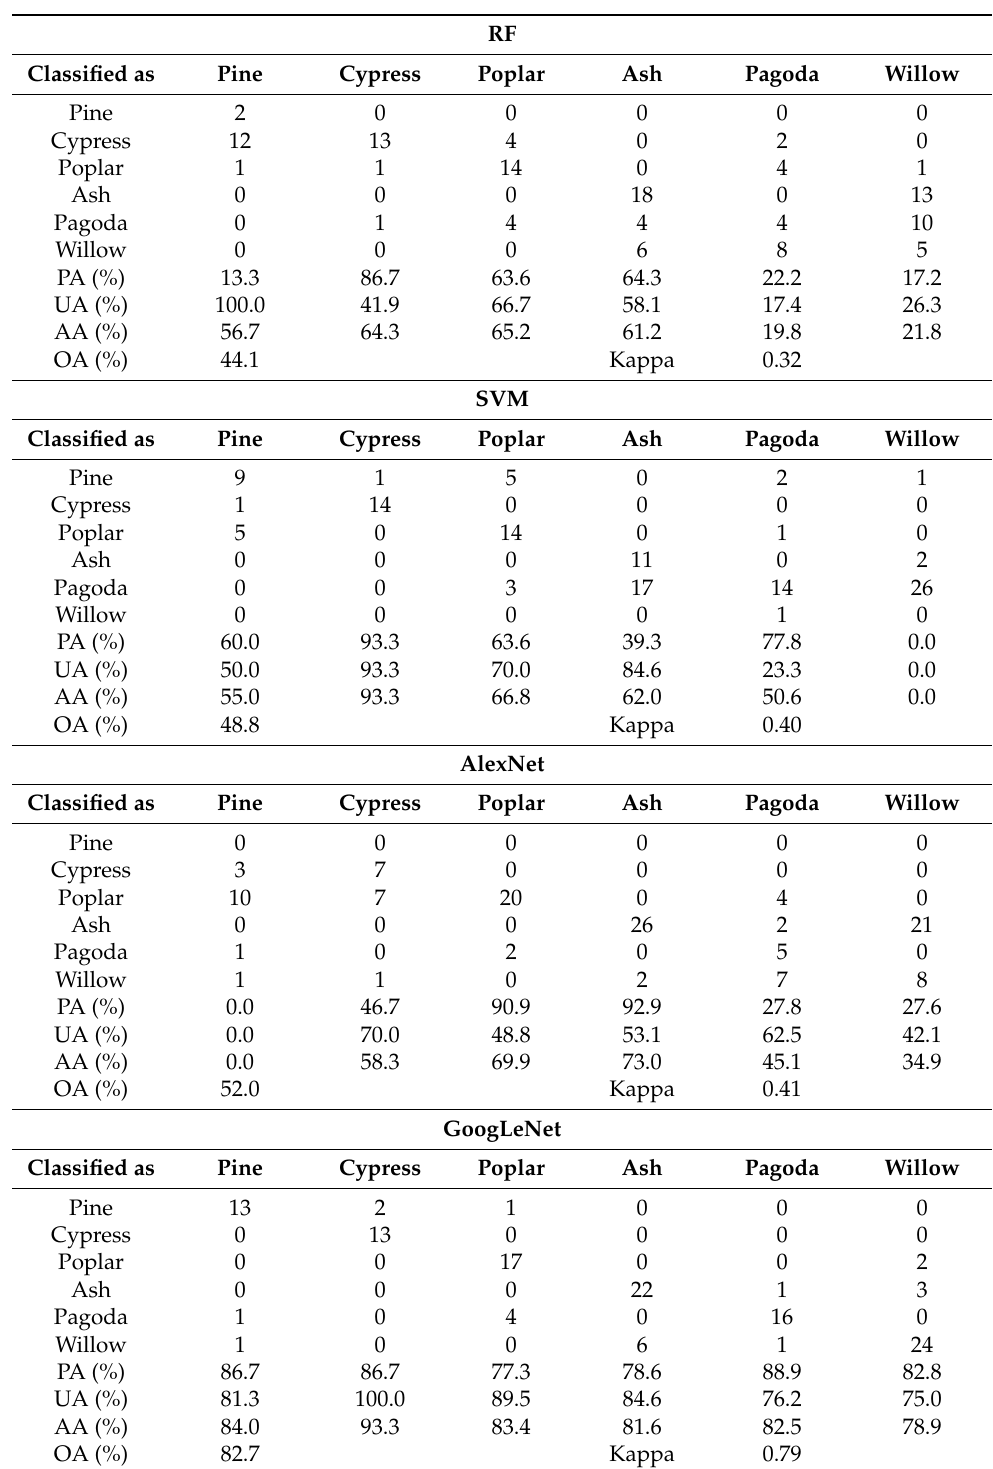
Table 8. Confusion matrix and statistical measures of RF, SVM, AlexNet, GoogLeNet, and ResNet for individual tree species classification. PA, producer accuracy; UA, user accuracy; AA, average accuracy; OA, overall